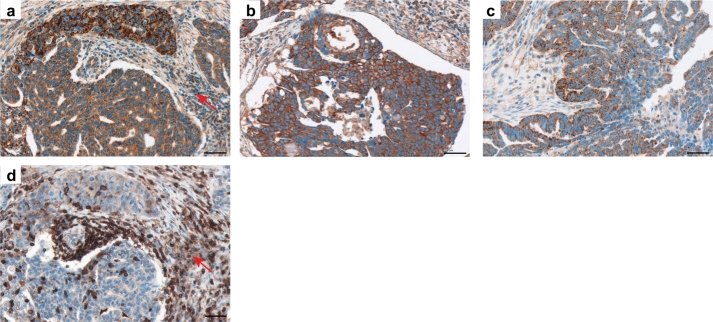
Expression of LPAR3 in ovarian cancer specimens. Immunohistochemical staining of tissue sections obtained from patients with serous ovarian cancer. Representative images of LPAR3 staining of three ovarian cancer specimens are shown (a-c). The tumor-infiltrating leukocytes are indicated by an arrow in (a) and visualized by anti-CD45 staining of consecutive slide in (d). Brown color, LPAR3 or CD45 staining; blue color, nuclear counterstaining with hematoxylin. Scale bar: 50 μm. (For interpretation of the references to color in this figure legend, the reader is referred to the web version of this article.)